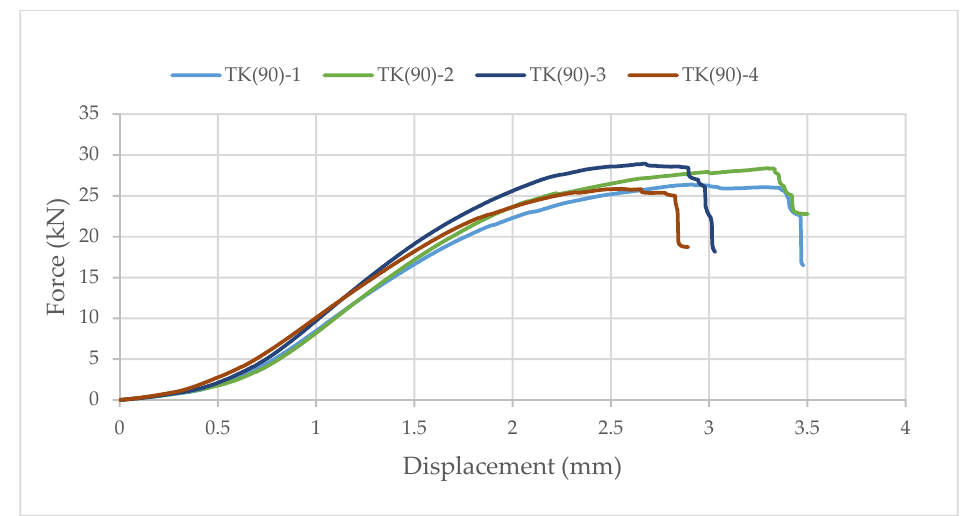
Figure 24. The force-displacement curve for compression perpendicular to the grain of samples with elliptical cavities in the direction of the stronger axis.